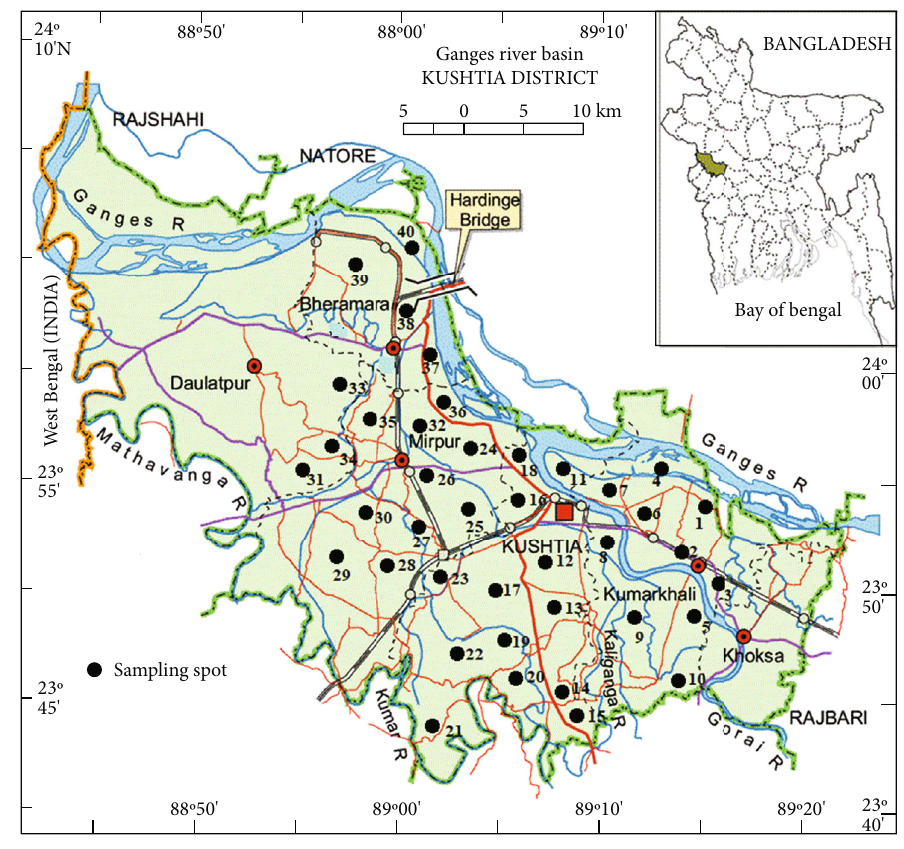
Figure 1: Location of groundwater